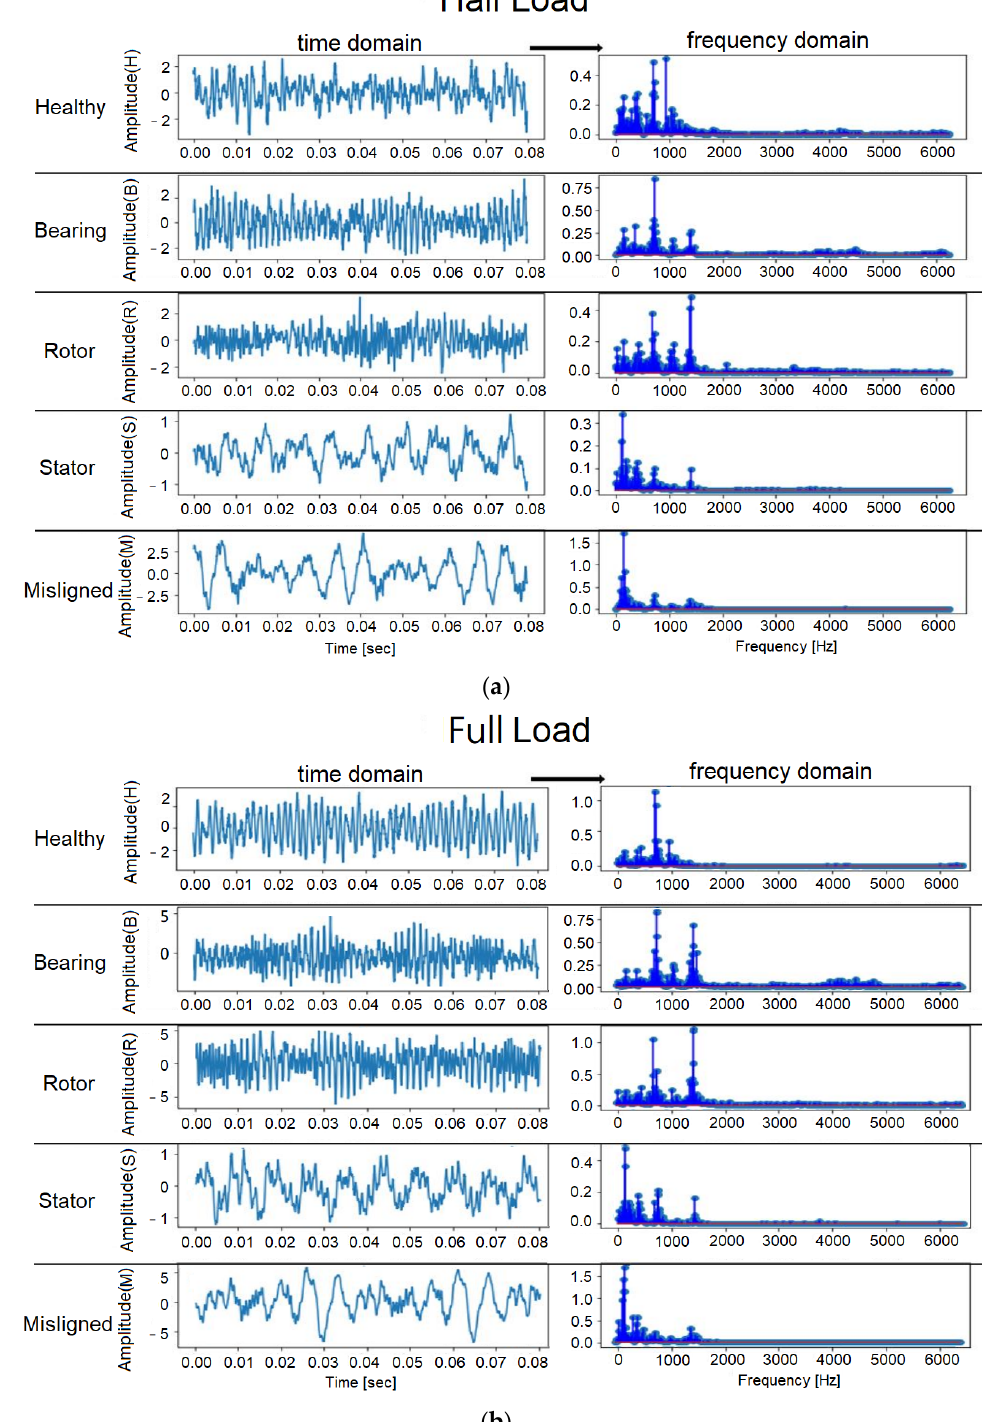
Figure 8. Five operating states in the time domain and frequency domain diagrams: ( a ) Half load; ( b ) Full load.